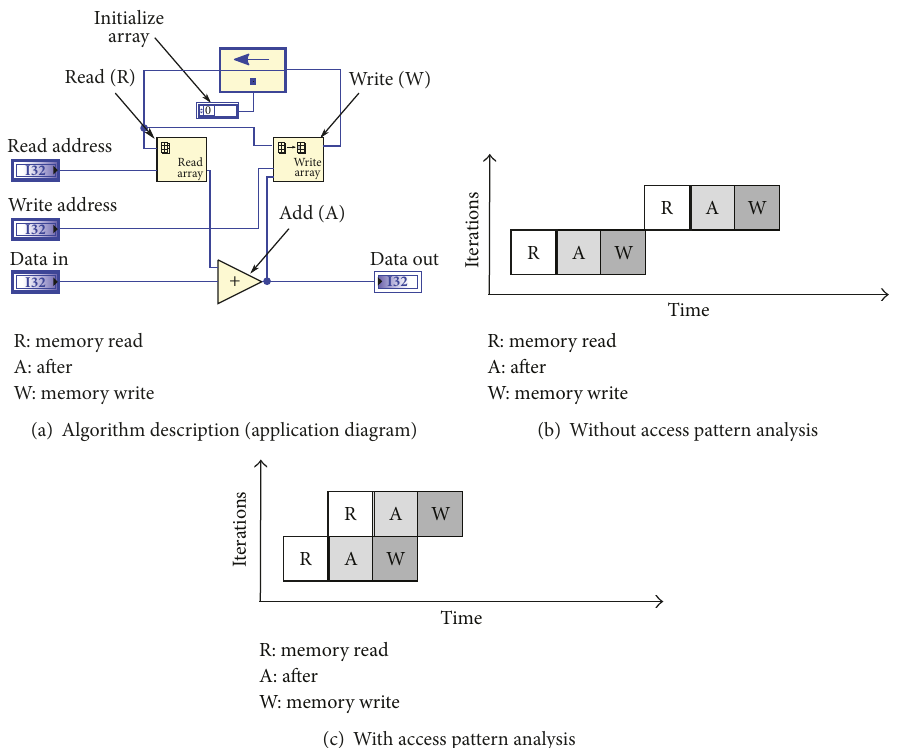
Figure 5: Throughput improvement using access pattern analysis. Shown on (a) is the representative schematic of the LabVIEW graphical programming virtual instrument (VI), and on (b and c) are the corresponding timing